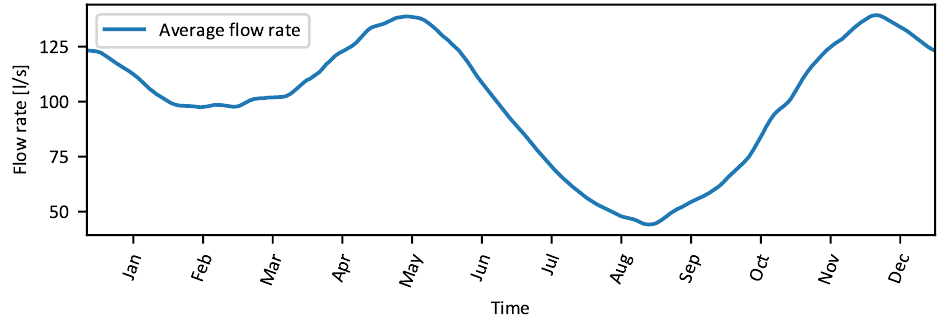
Figure 6. Average available flow rate at the MHP